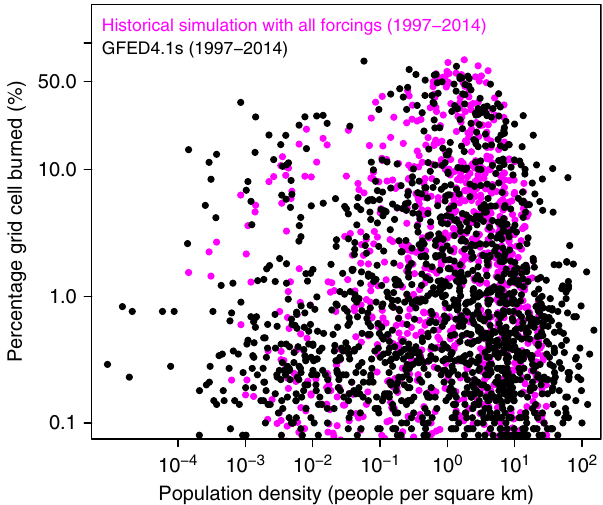
Fig. 5 The emergent behavior between area burned and population density. Population density and percentage area burned are both plotted on log scale for easy visualization of their behavior at their low values. Comparison is made between simulated (historical simulation with all forcings) and satellite-based (GFED4.1s) values of area burned. The model successfully reproduces the unimodal relationship between population density and area burned which peaks at around 20 people/km